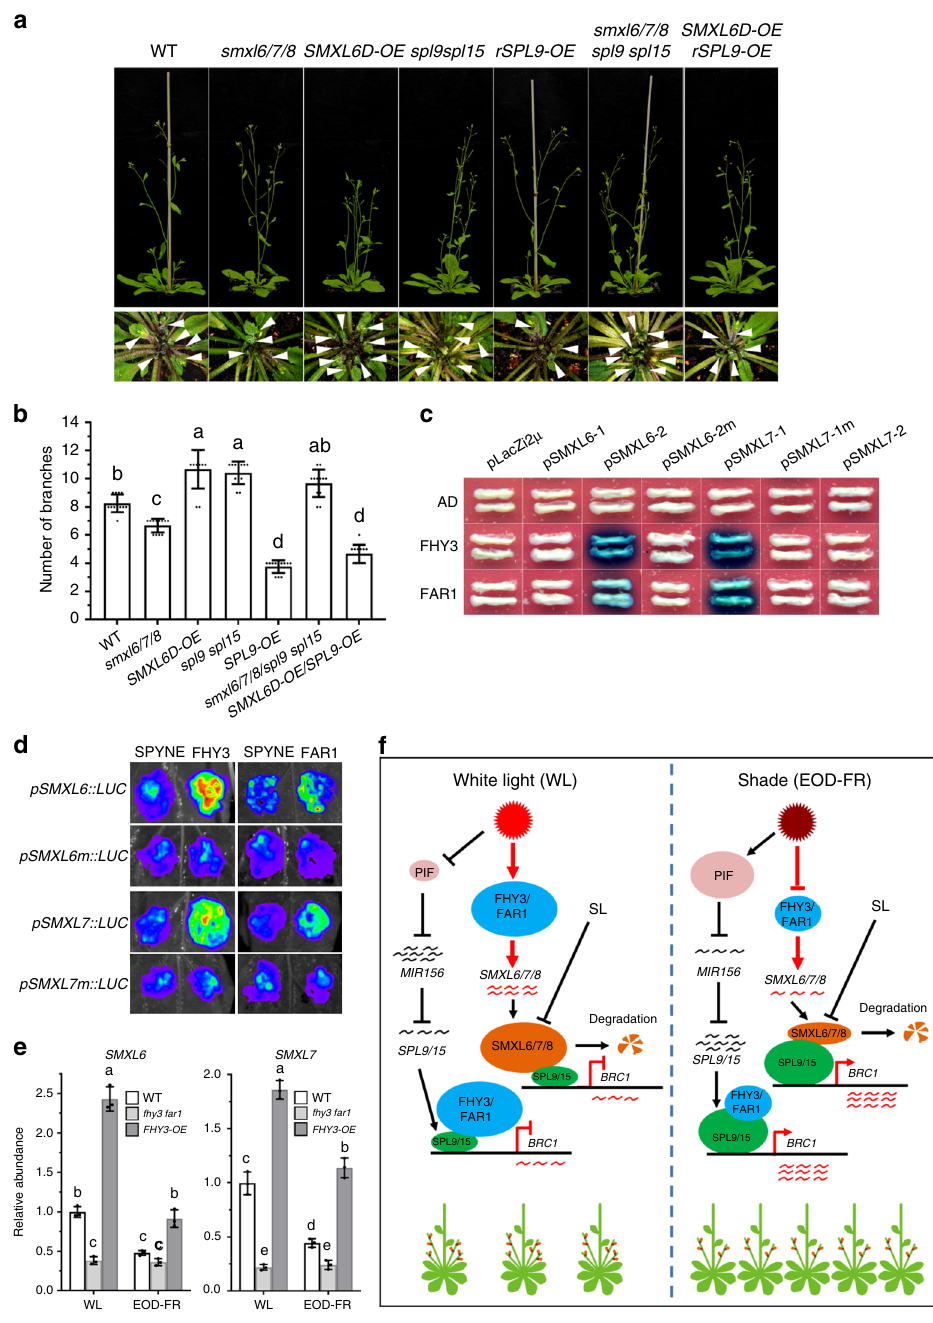
Fig. 6 FHY3 and FAR1 directly upregulate the expression of SMXL6 and SMXL7 . a Comparison of the rosette branch number of smxl6/7/8 , spl9 spl15 , SMXL6D-OE , rSPL9-OE , and their higher order mutants grown under normal conditions. Eight-day-old seedlings were moved into the soil and grown under normal conditions for 4 weeks before phenotyping. Arrow indicates the short rosette branches. b Quanti fi cation of the number of rosette branches of fhy3 far1 , spl9 spl15 , FHY3-OE , rSPL9-OE , and their higher order mutants. Values shown are mean ± SD ( n = 12). Letters indicate signi fi cant differences by two- sided LSD test ( p < 0.05). c Yeast one-hybrid assay shows that FHY3 and FAR1 bind to the promoters of SMXL6 and SMXL7 . pLacZi2 μ and JG served as the negative controls. d Transient expression assay shows that FHY3 and FAR1 promote the expression of SMXL6 and SMXL7 . Representative images of N. benthamiana leaves 72 h after in fi ltration were shown. e Comparison of the expression levels of SMXL6 and SMXL7 in 7-day-old wild type, fhy3 far1 and FHY3-OE seedlings grown under normal white light or simulated shade (EOD-FR) conditions. Values given are mean ± SD ( n = 3). Different letters indicate signi fi cant differences by two-sided LSD test ( p < 0.05). f A simpli fi ed schematic model depicting FHY3 and FAR1 integrate light and strigolactone signaling to regulate branching. FHY3/FAR1 and SMXL6/SMXL7/SMXL8 directly interact with SPL9 and SPL15 and suppress their transcriptional activation of BRC1 , meanwhile FHY3 and FAR1 upregulate the expression levels of SMXL6 and SMXL7 and thus promote branching. Simulated shade treatment reduces the accumulation of FHY3 protein, leading to increased expression of BRC1 and reduced branching. Arrow: activate; Bar: